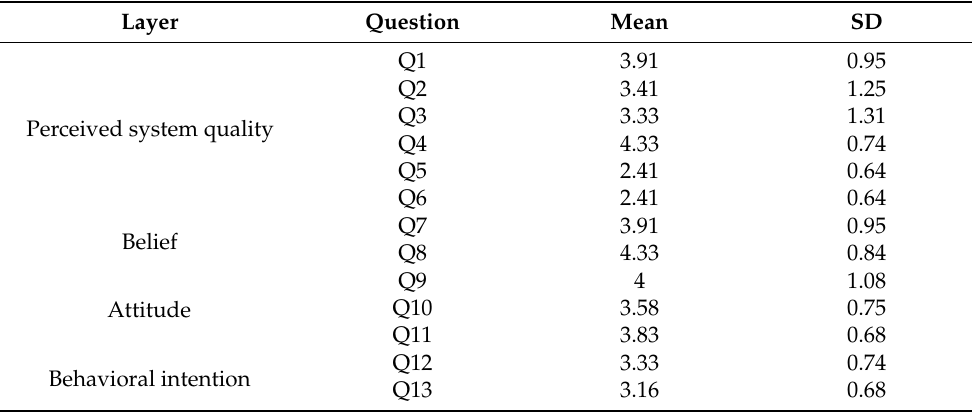
Table 6. Post-test questionnaire